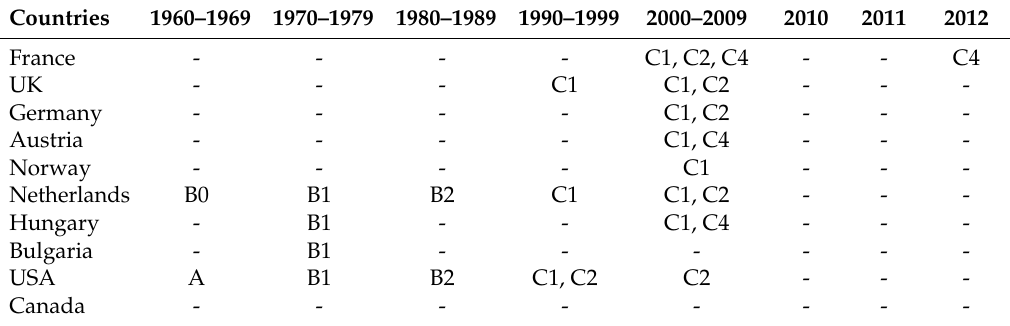
Table 2. A summary of human enterovirus 71 genotypes circulating outside the Asia-Pacific